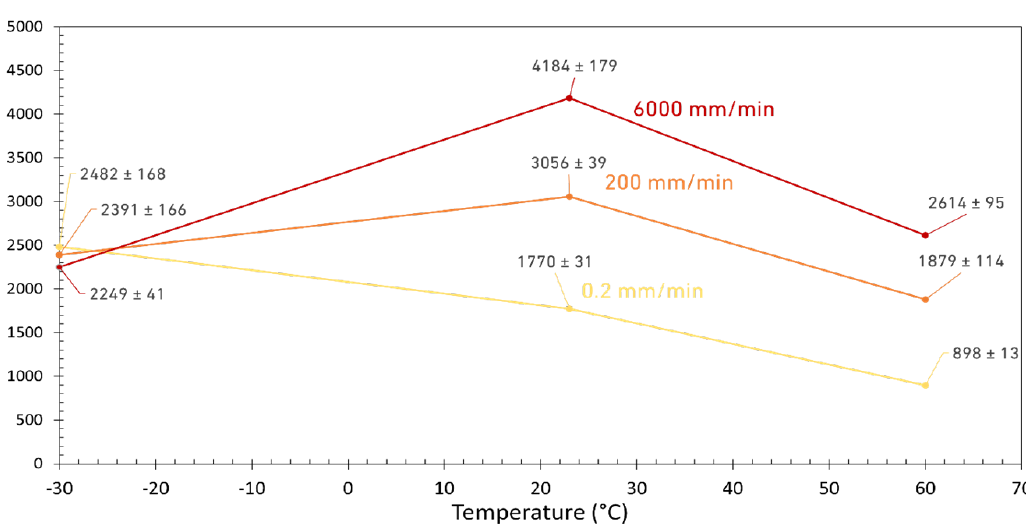
Figure 6. Maximum displacement as a function of temperature for three different loading rates.